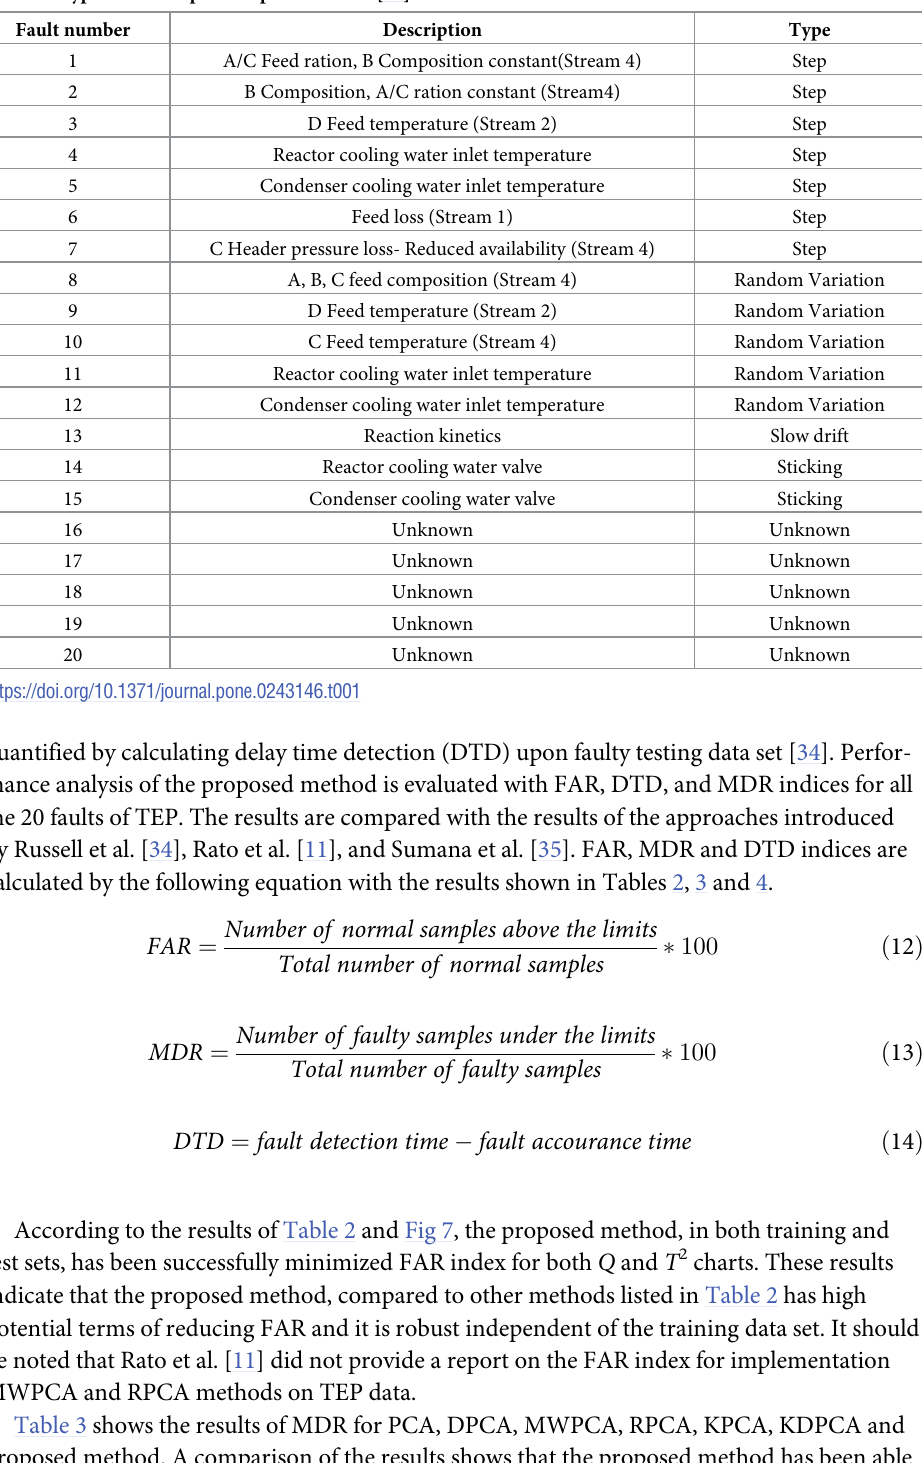
Table 1. Type and description of process faults